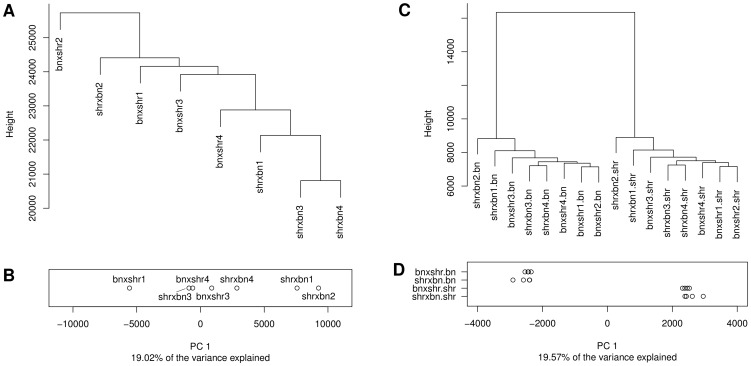
Hierarchical clustering and principal component analysis of CpG methylation profiles obtained in the F1 reciprocal crosses.Dendrograms showing the results of clustering the CpG methylation profiles obtained in each of the F1 animals before (A) and after (C) phasing the read data by parental genotype. The prefix of the phased F1 profiles in (C) denotes the reciprocal cross (bnxshr, shrxbn) and the suffix the genotype of the phased read set (bn = Brown Norway, shr = Spontaneously Hypertensive Rat). Numbers after the reciprocal cross prefix denote biological replicates. Profiles were clustered by the Ward's method using the pairwise euclidean distance between the profiles as the distance metric. Panels B and D show the projection of methylation profiles onto the 1st principal component (PC). Replicates for each cross-genotype combination are separated along the y-axis. The prefix of the label denotes the reciprocal cross (bnxshr, shrxbn), the suffix denotes the parental genotype (bn, shr). While the 1st PC does not separate crosses in the unphased data it provides complete separation by parental genotype in the phased data. Only CpGs with at least 5× coverage in each replicate/phased read set were included in the analysis and CpG positions affected by SNPs/indels were removed prior to clustering and principal component analysis.